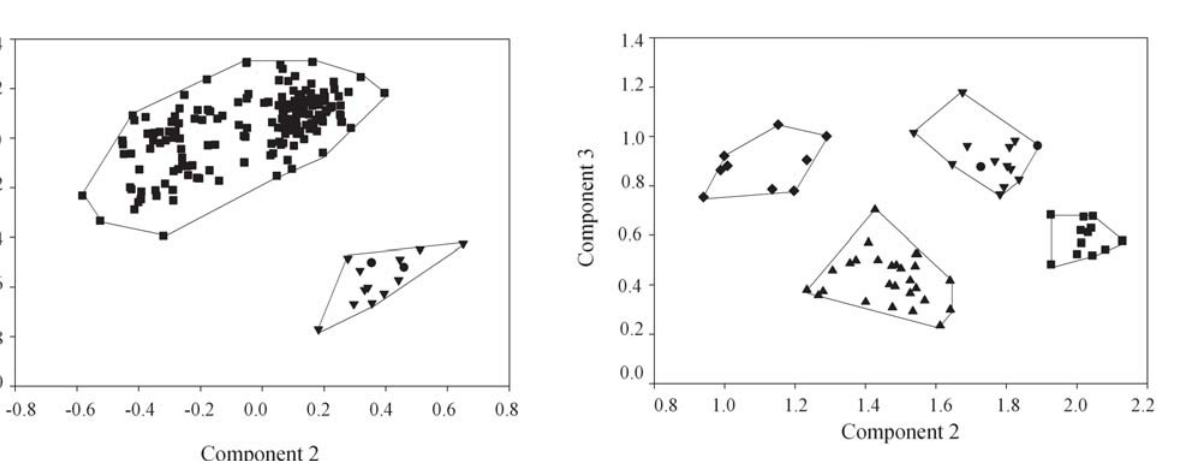
Fig. 1 . Principal components analysis on covariance matrix of log-transformed measurements of Pimelodus microstoma from the upper Paraná (inverted triangles), syntypes of Pimelodus microstoma (dots), and Pimelodus blochii species-group (squares).